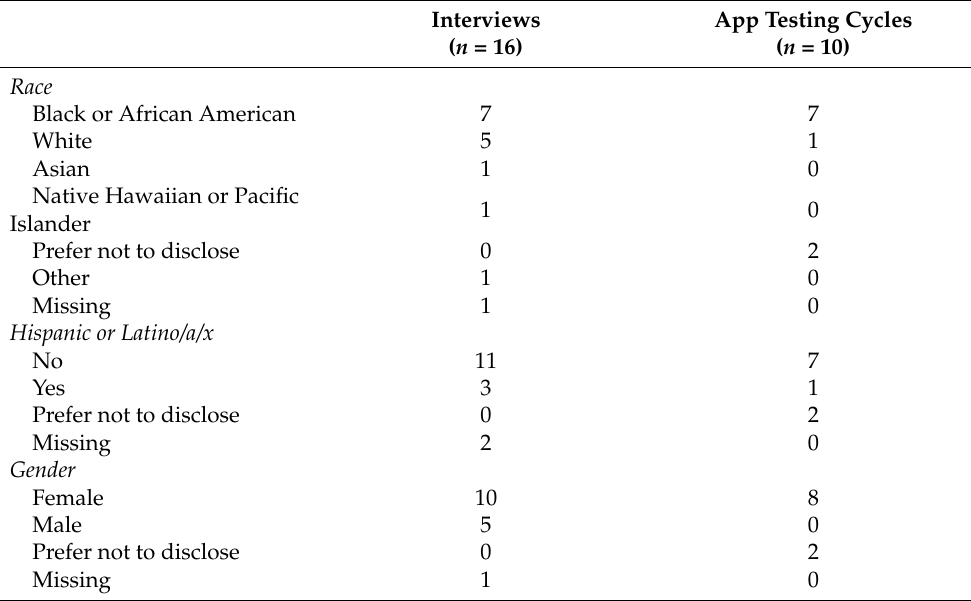
Table 1. Participant demographic